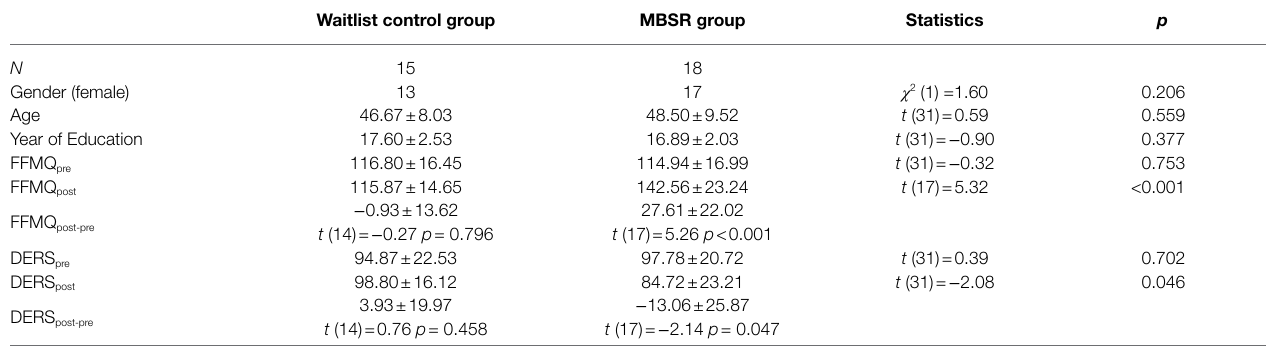
TABLE 1 | Demographic data and questionnaire